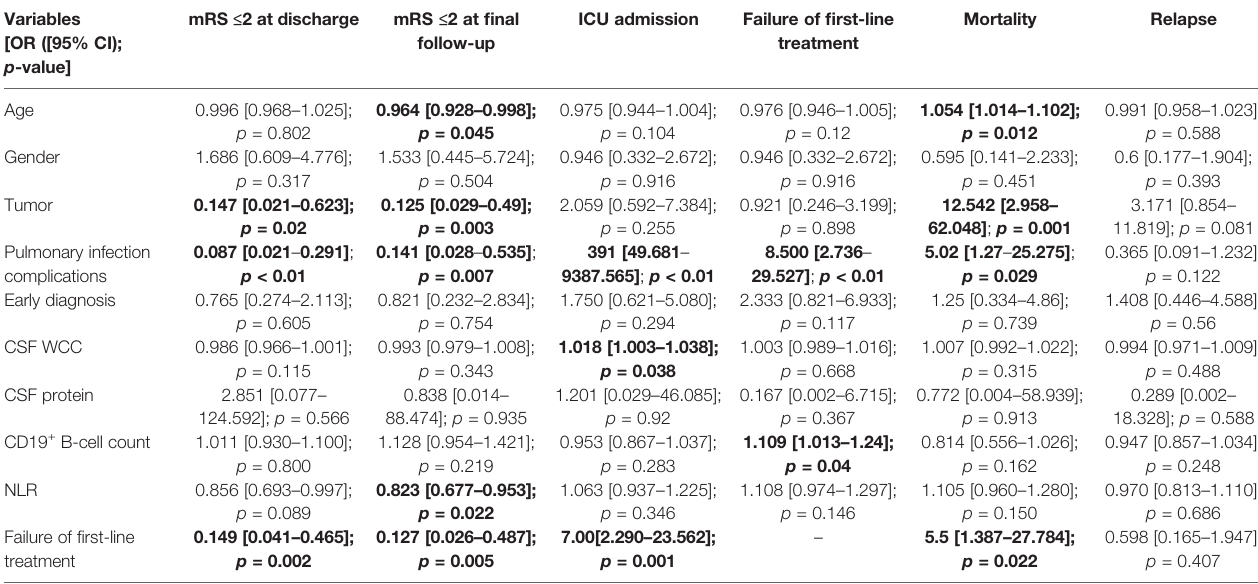
TABLE 3 | Univariate logistic regression analysis for all severe AE